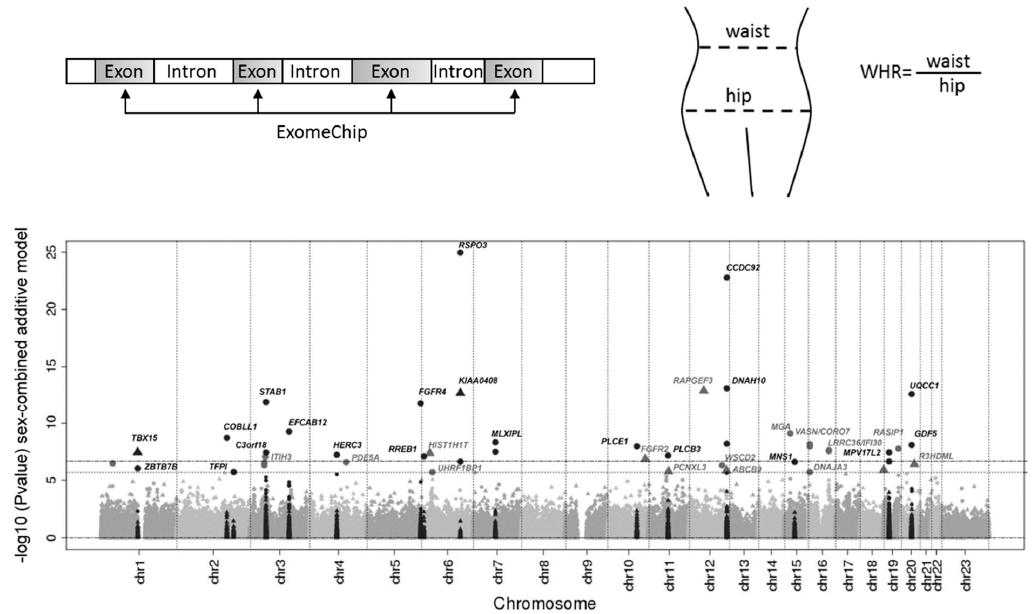
Figure 2. GWAS of body fat distribution assessed by waist-to-hip ratio adjusted for body mass index.